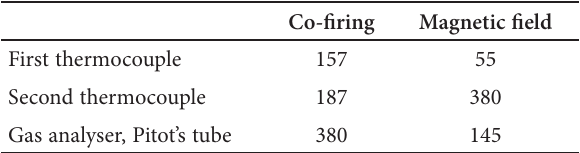
Table 2. The placement of the measurement instruments above the propane-butane burner Co­firing Magnetic field First thermocouple 157